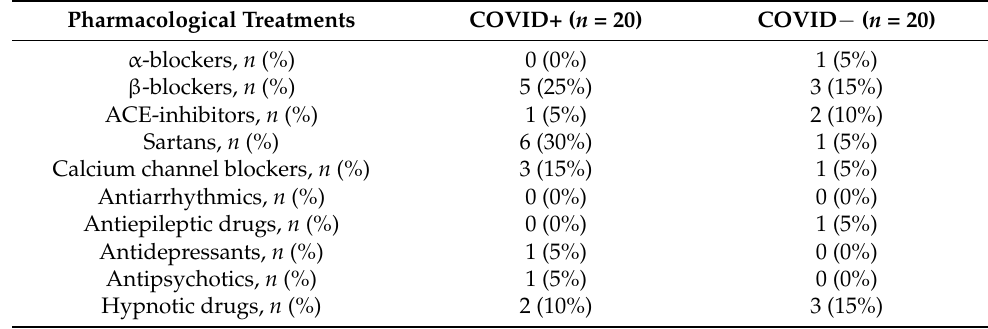
Table 2. Concomitant pharmacological treatments of COVID+ and COVID − groups. Variables are